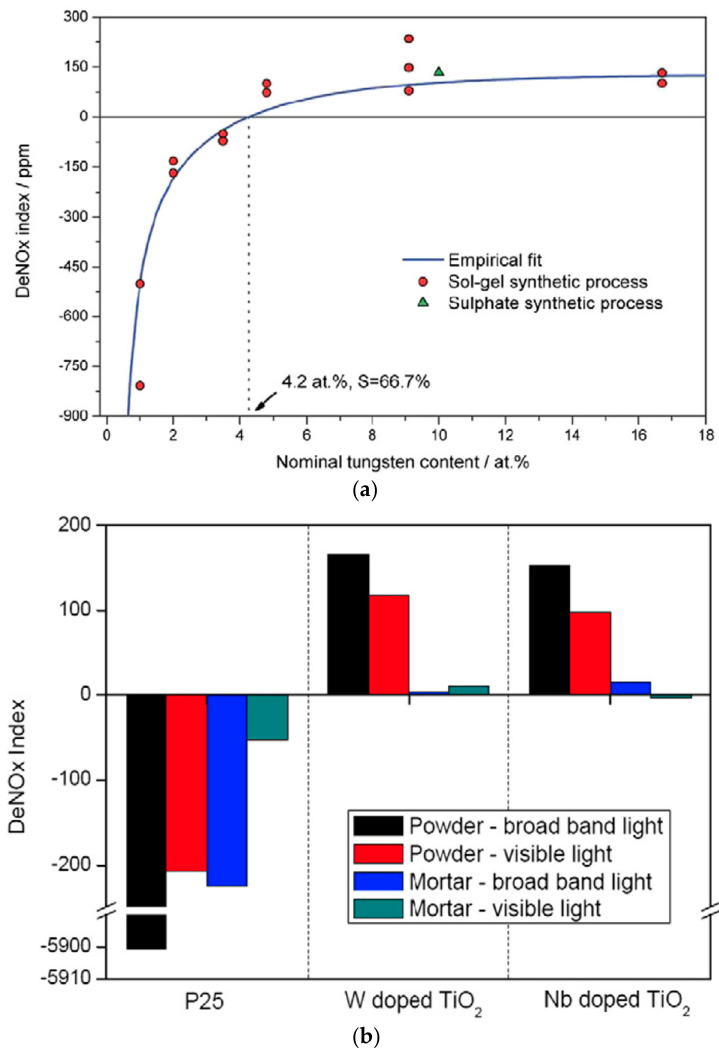
Figure 42. ( a ) deNO x index measured using W-doped TiO 2 under broad band radiation simulating sunlight; and ( b ) deNO x data on powder and mortar samples containing W-and Nb-doped TiO 2 (broad band and visible light exposure). Reproduced with permission from Macphee and Folli [129]. Copyright 2016 by Elsevier Ltd. (License No.: 4453091259877).